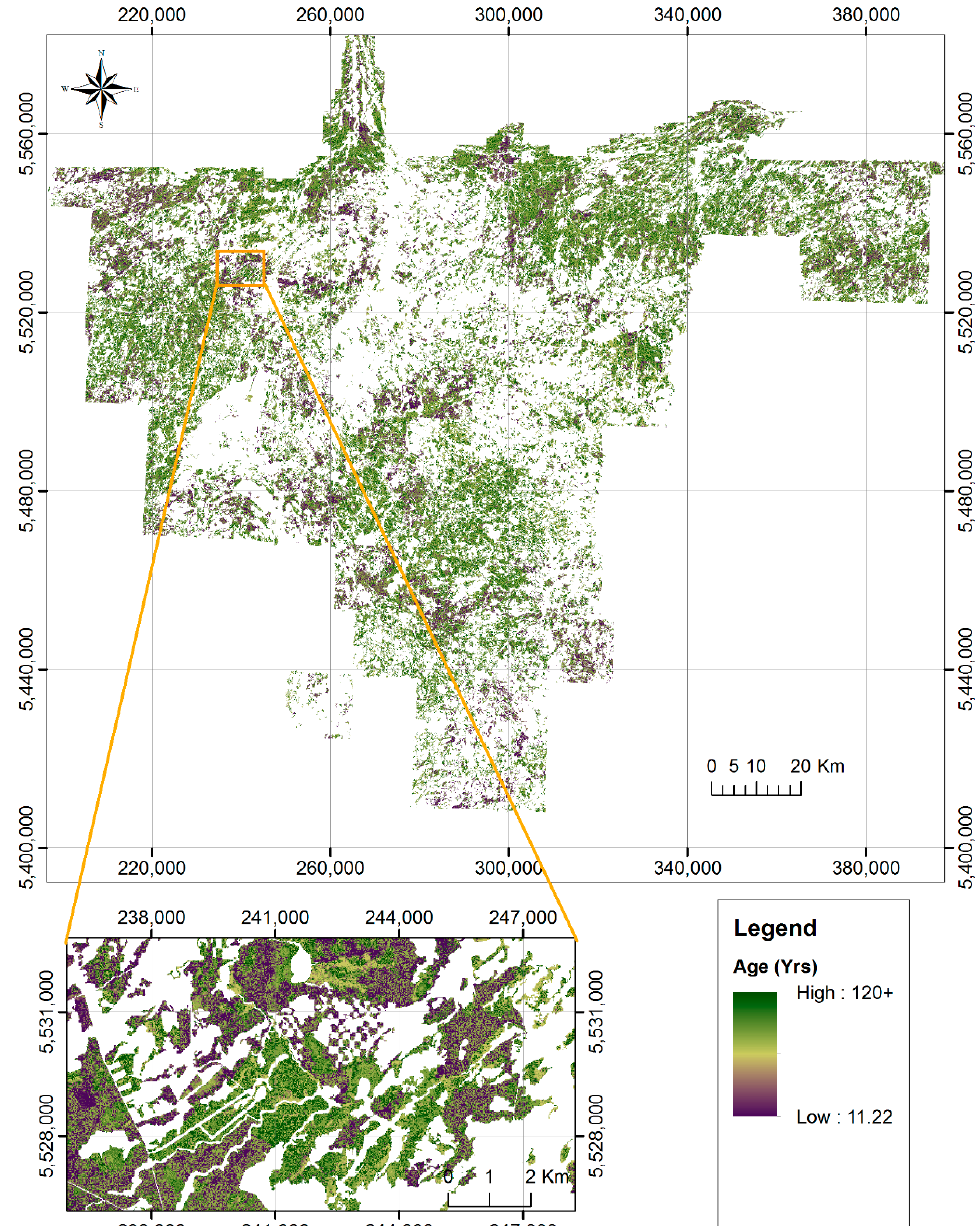
Figure 7. Mean age (years) imputation for FRI polygons that met rf-kNN model requirements, using ALS structural metrics (MAX, cc4, cc10, cc16, P50, COVAR, Elevation and TWI) Hearst Forest in Northeastern Ontario.